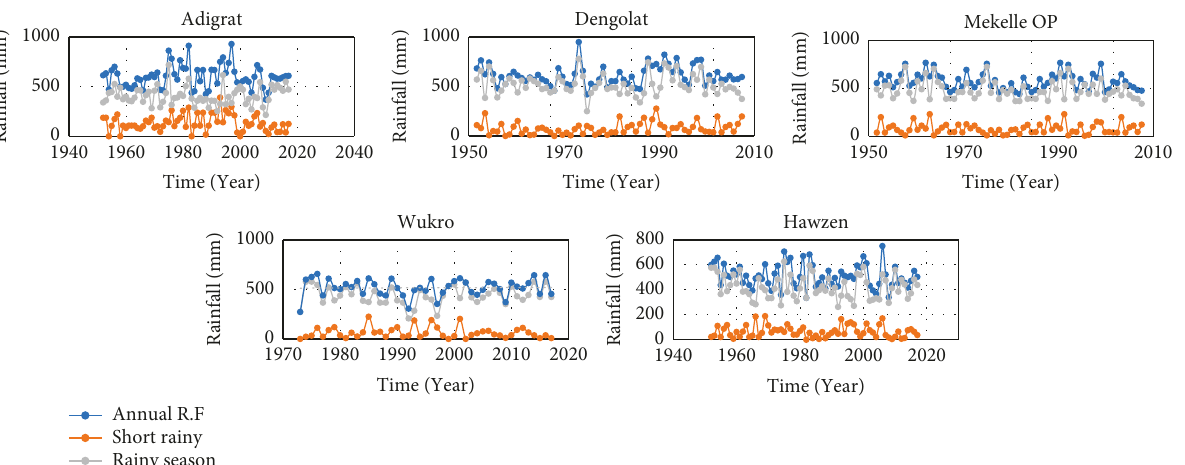
Figure 5: Seasonal temporal variability of rainfall (mm) in stations of 43–65 years of